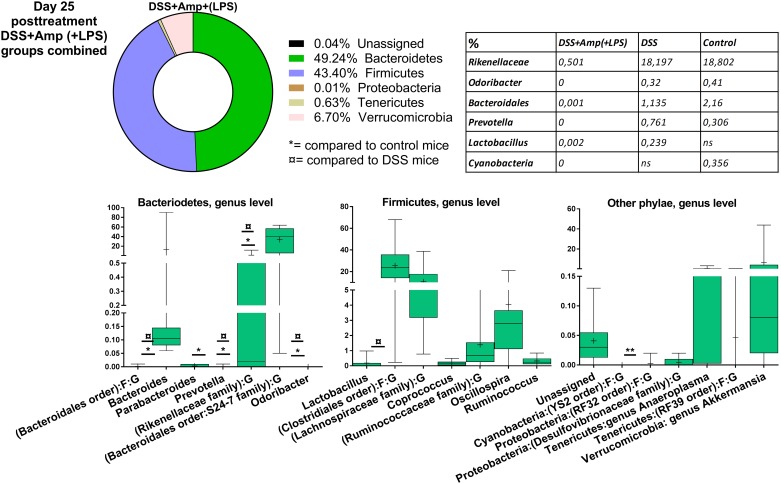
Distribution of the 20 most abundant phyla on day 25 post-treatment (DSS+Ampicillin (+LPS) groups combined).Overview of relative phylogenetic distribution and details of variation down to genus level of gut microbiota of untreated control mice compared to mice 25 days post-treatment with 1.5% dextran sulfate sodium (DSS), 1g/L ampicillin (Amp) and/or diet containing 40.8 mg/kg lipopolysaccharides (LPS). There were too few reads from DSS+Amp and DSS+Amp+LPS mice on day 3 and day 1 post-treatment. As no qualitative or quantitative differences in bacterial composition were found between DSS+Amp mice and DSS+Amp+LPS on day 25 post-treatment, these groups were combined for this time point. See Fig 5 for control group and DSS group. See S2 Table for analysis of variance.